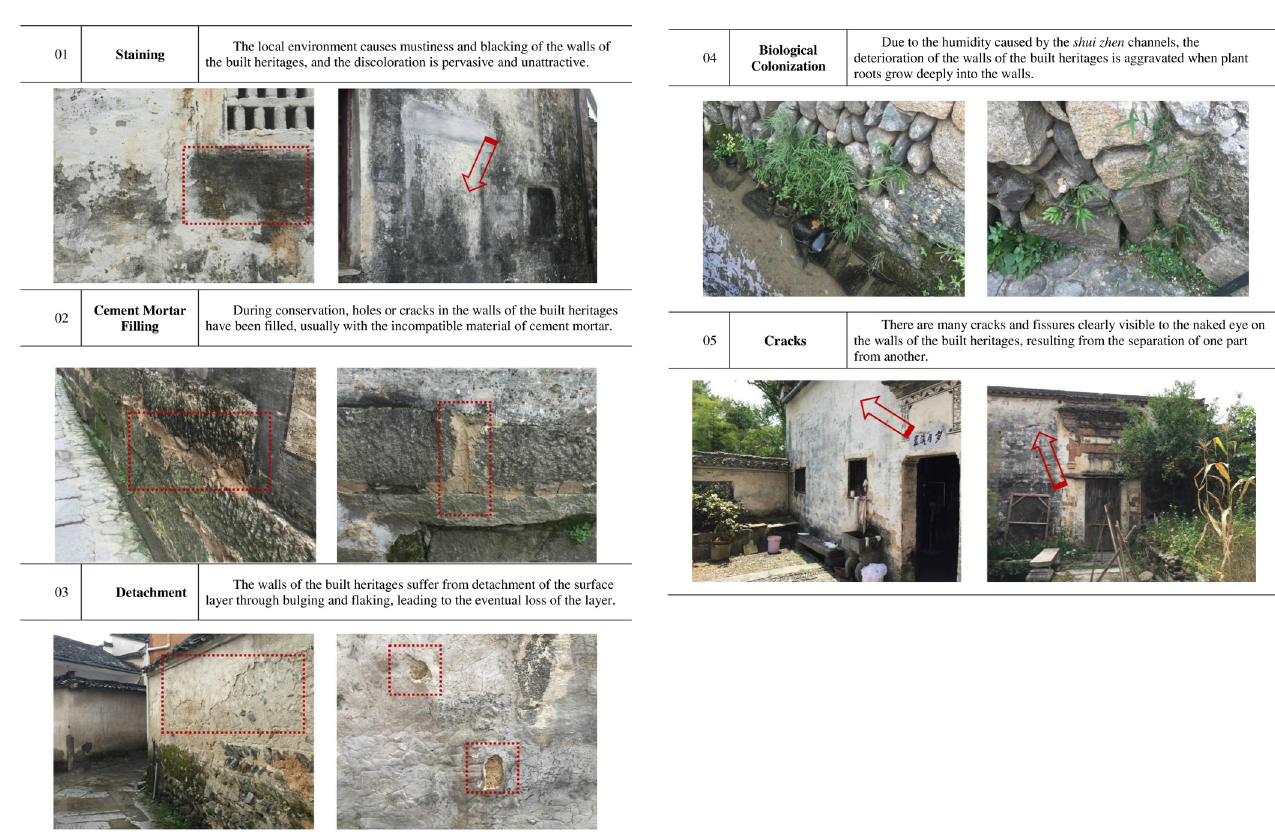
Fig 4. Main decay phenomena of masonry components of traditional